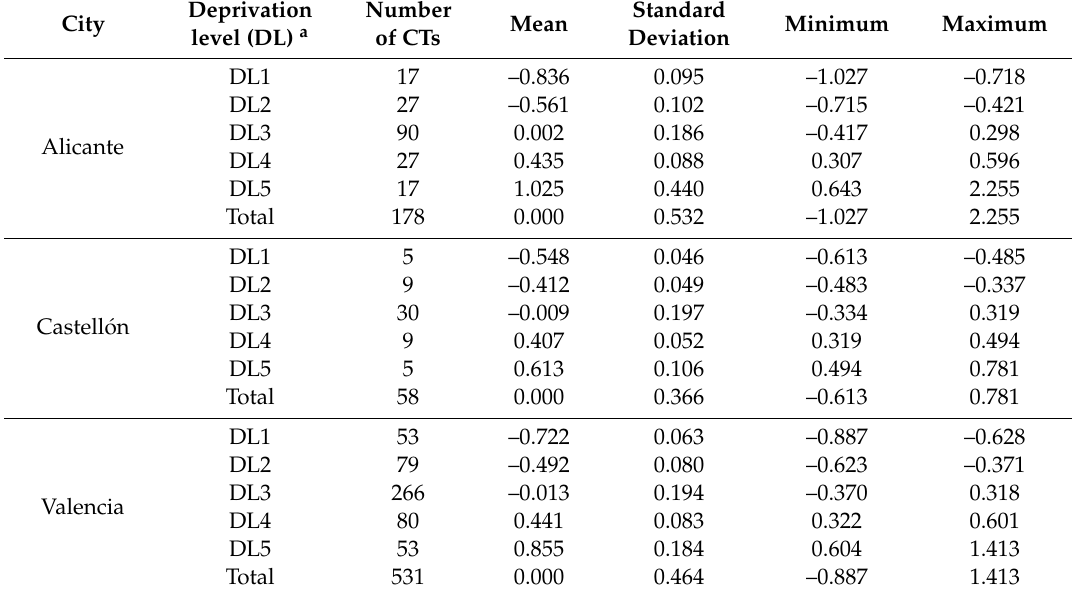
Table A2. Descriptive characteristics of the deprivation index according to deprivation classification percentiles for the census tracts of each